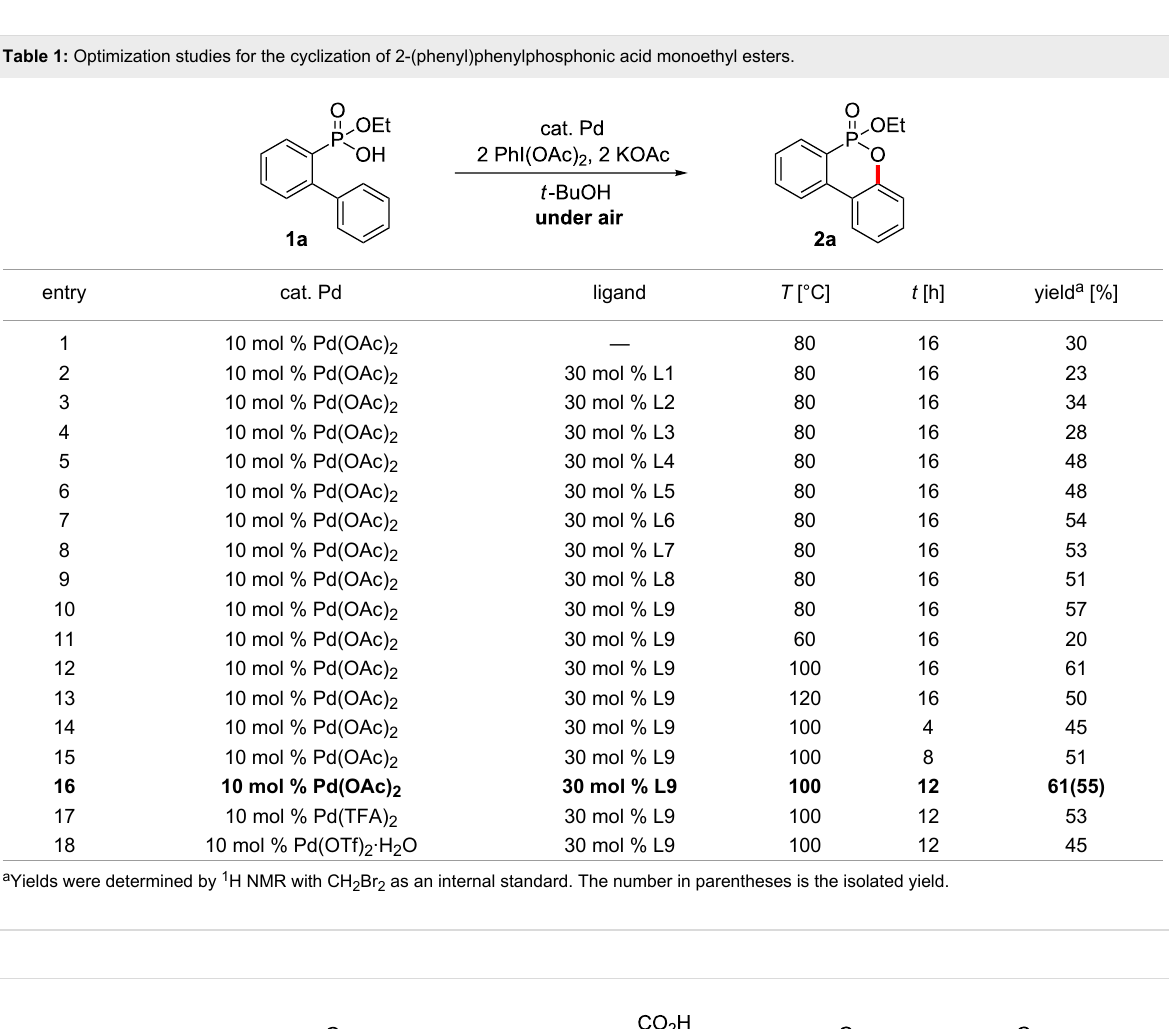
Table 1: Optimization studies for the cyclization of 2-(phenyl)phenylphosphonic acid monoethyl esters.